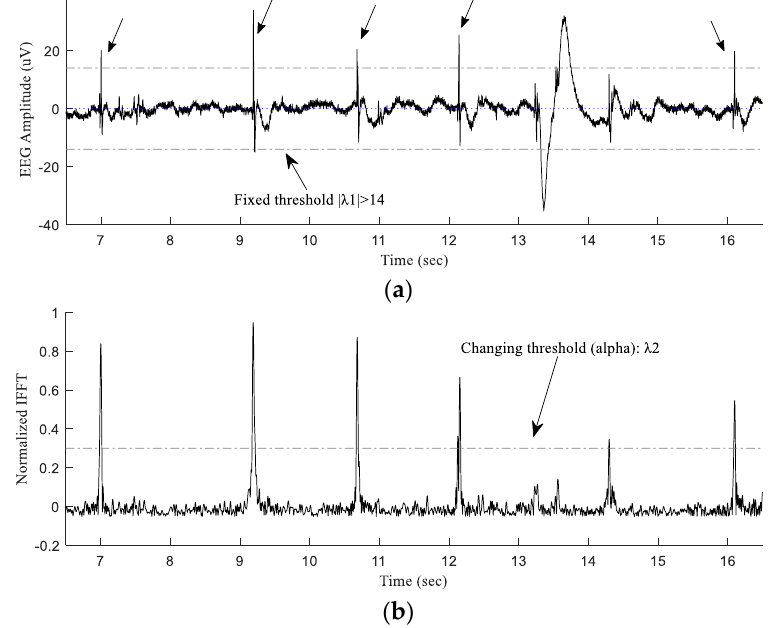
Figure 3. ( a ) A section taken from Figure 1a, spikes are indicated with arrows. ( b ) The inverse FFT of the ECoG signal in ( a ) FFTed over the frequency range of 80–120 Hz. λ 1 is fixed at 14 µ V and λ 2 (alpha) varies between 0.1 and 0.95.